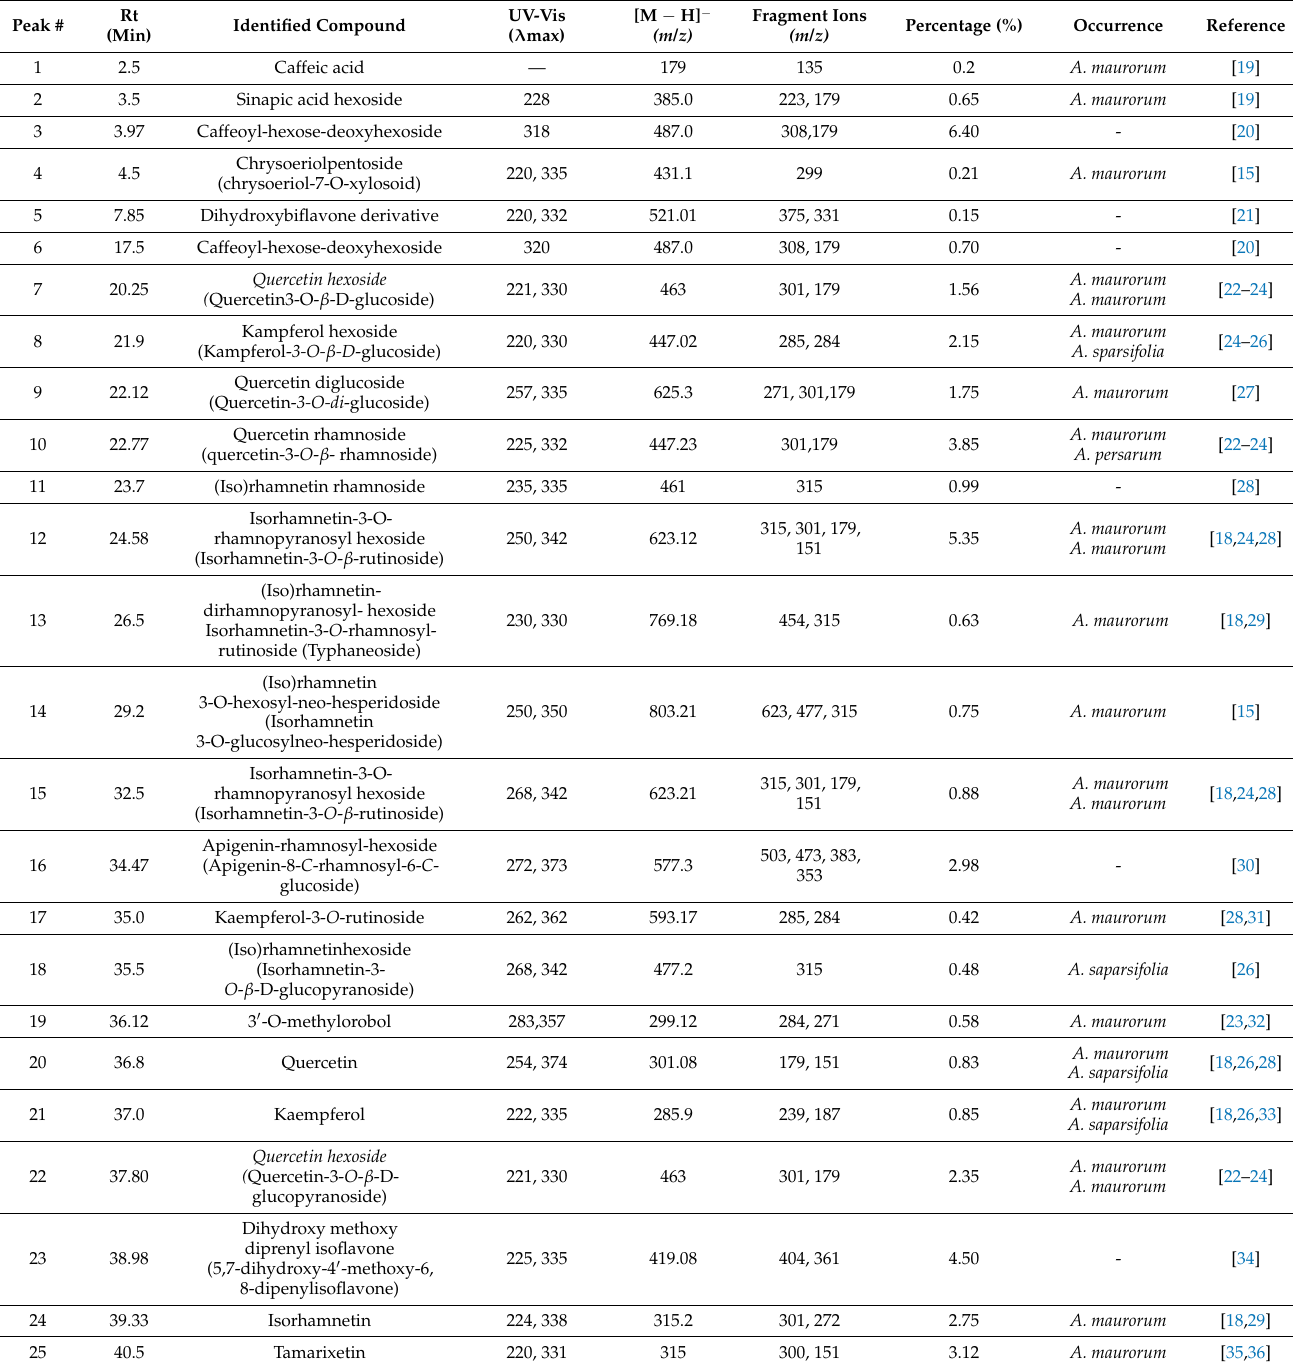
Table 2. Peak assignment of the metabolites detected in the ethyl acetate fraction of A. maurorum using UPLC-PDA-ESI-MS/MS (negative